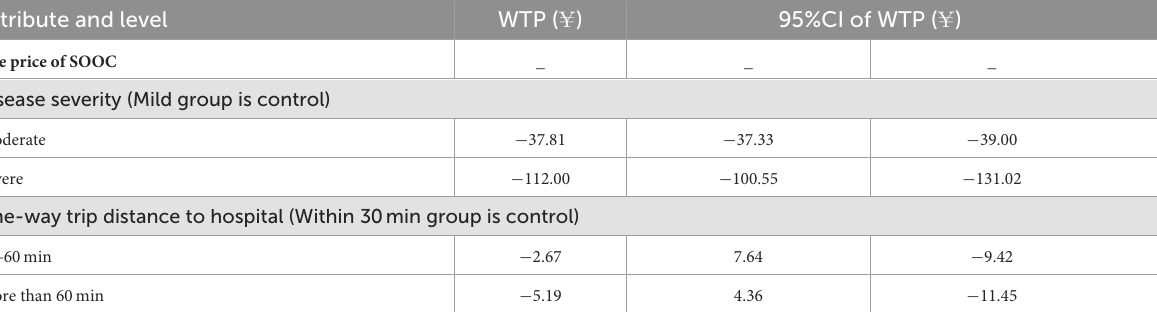
TABLE 5 WTP estimates for SOOC attributes.